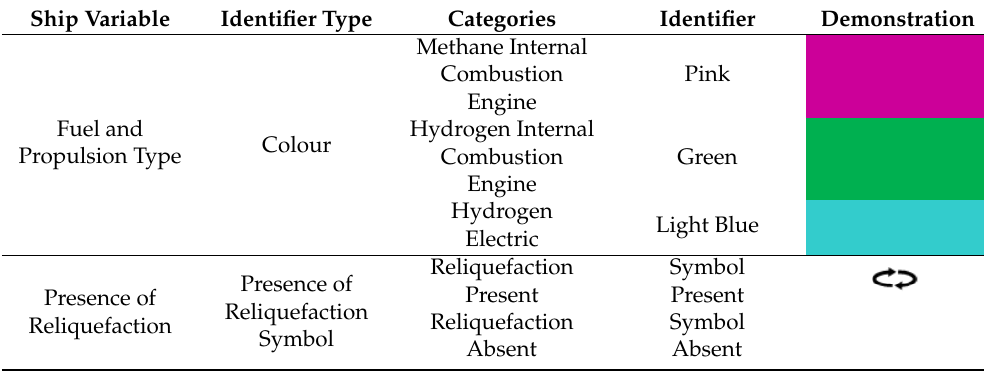
Table 11. Estimated ship properties, set to maximise the delivered mass after 20 days for all inves- tigated ship designs: (a) thickness of insulation and component masses; (b) component volumes, fuel depletion rate, and revenue loss rate